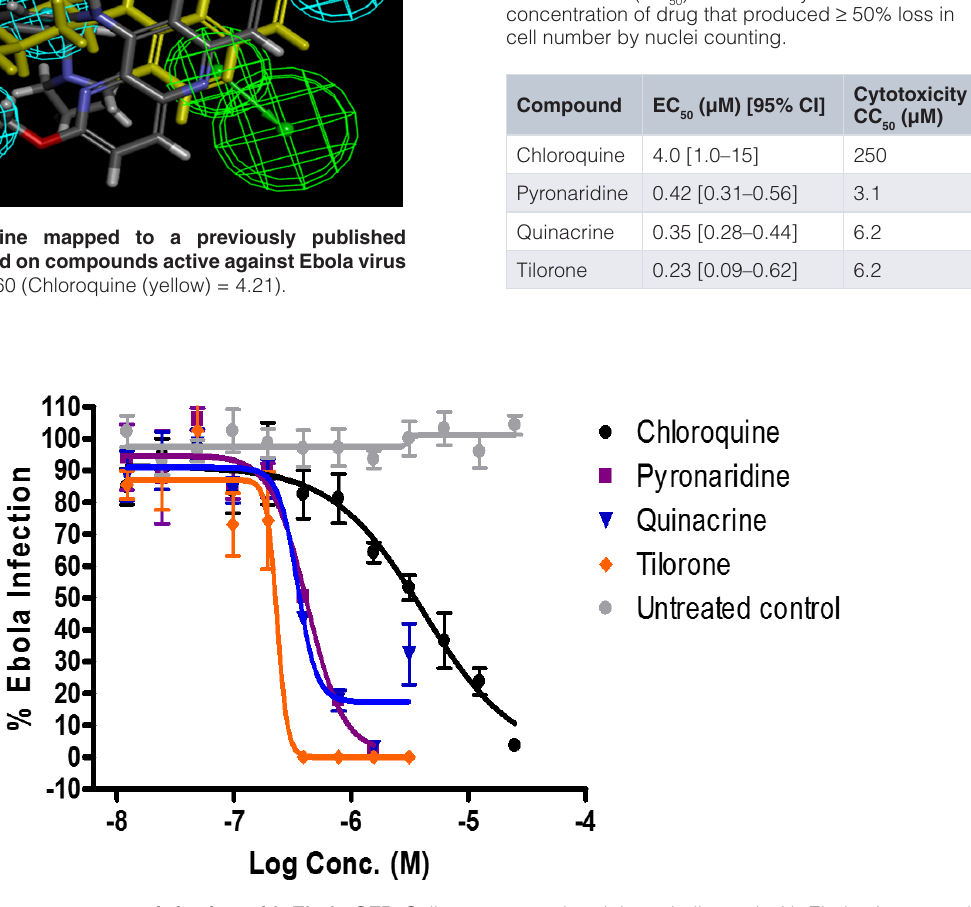
Figure 5. Effect of drug treatment on infection with Ebola-GFP. Cells were treated and then challenged with Ebola virus encoding GFP. Infection efficiency was calculated as infected cells (expressing GFP)/total cells and normalized to infection efficiency seen in the untreated control. Shown is one representative experiment where each point is the average of 3 independent measurements of infection +/- standard deviation. Dose response curves were fitted by non-linear